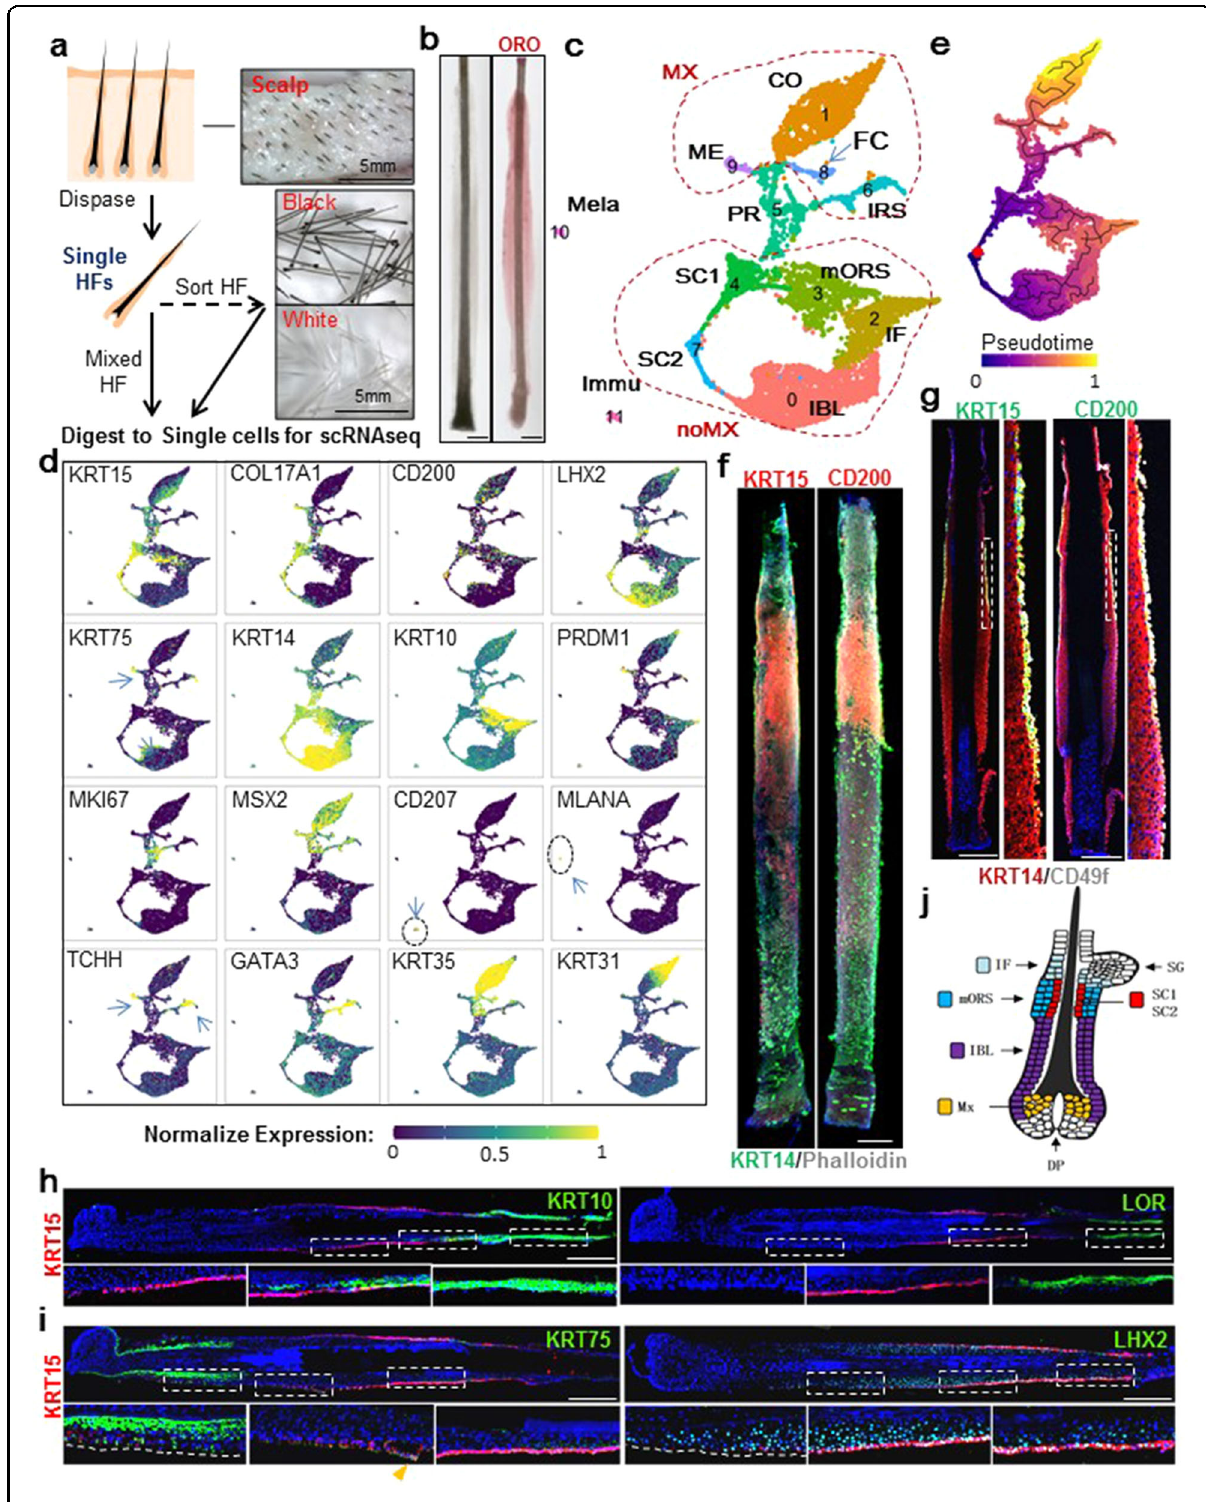
Fig. 1 (See legend on next